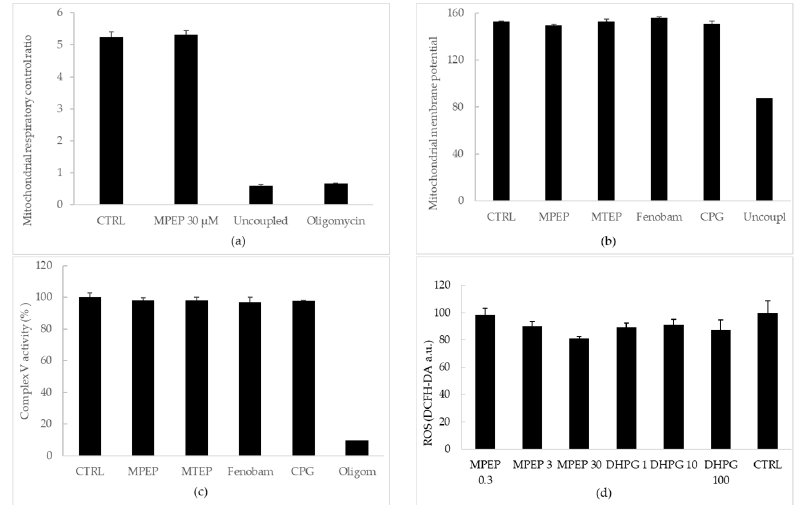
Figure 2. MPEP did not alter mitochondrial functionality. ( a ) MPEP 30 µM did not change respiratory